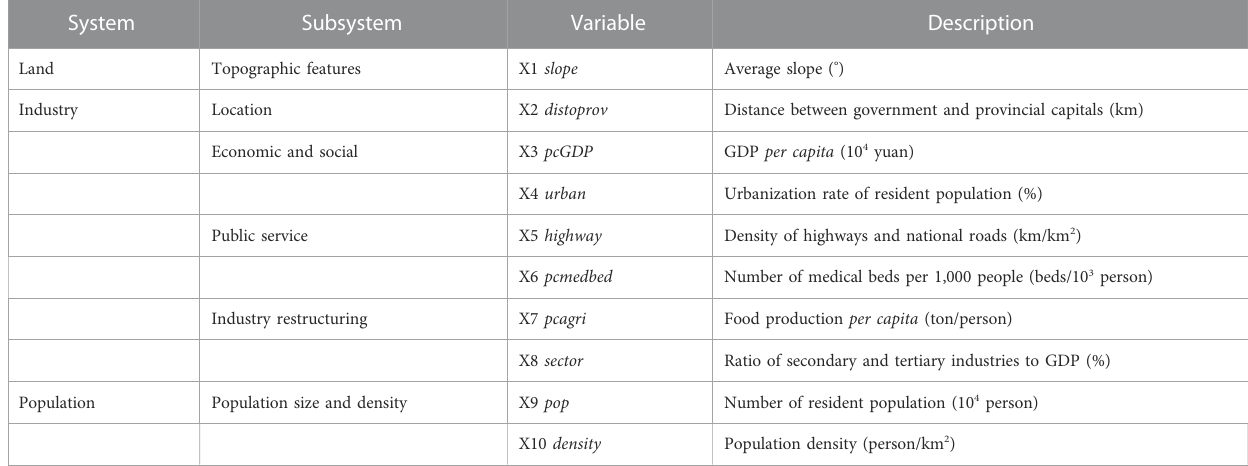
TABLE 1 Factors in fl uencing the intra city-size distribution in the